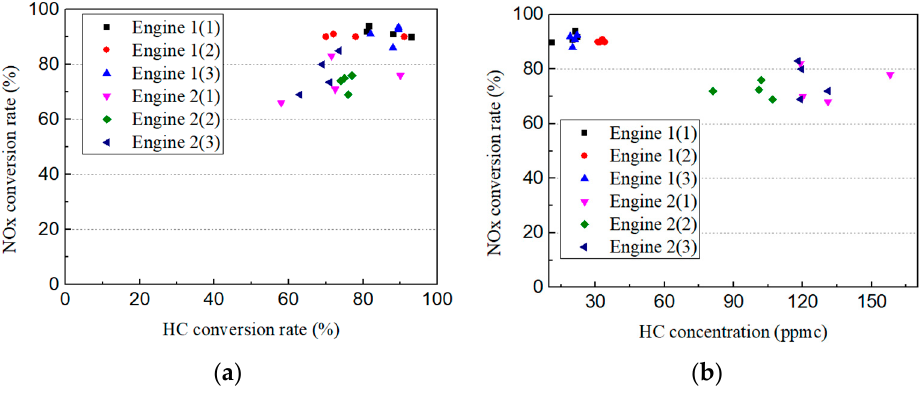
Figure 17. NOx conversion rate as a function of ( a ) HC conversion and ( b ) HC concentration from downstream of the catalyst.